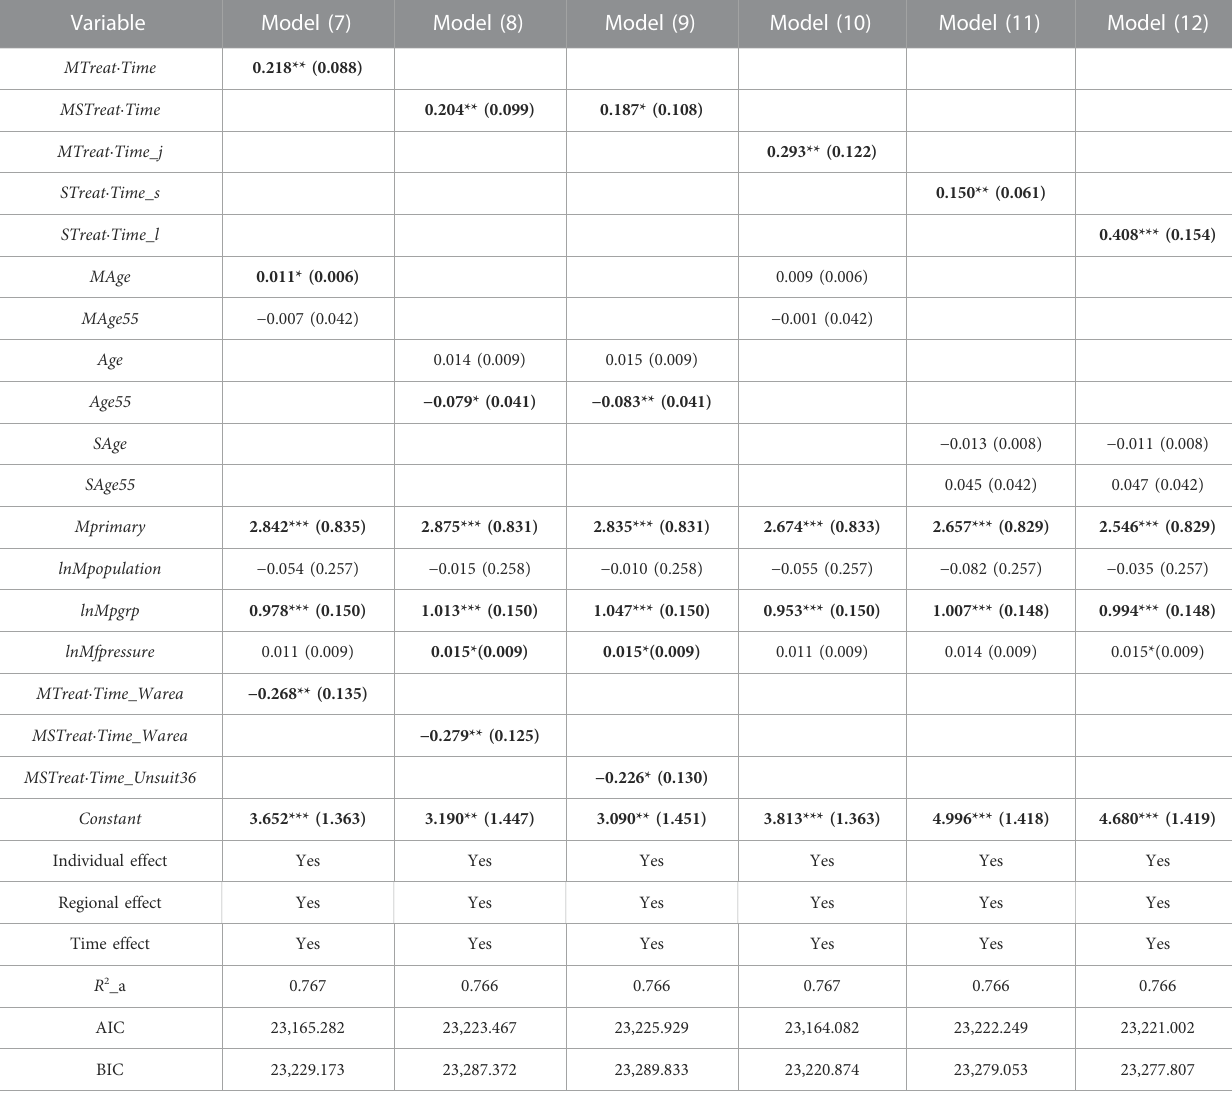
TABLE 3 Estimation results of regional difference on leading cadre ’ s